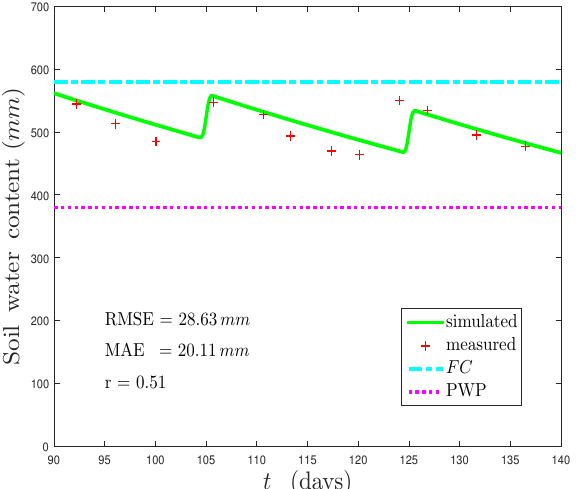
Figure 8. Soil water content trends for modeled and actual data for full irrigated wheat (using the calibrated parameters from Table 2, and measured data from Andarzian et al. [28]). Field Capacity (FC), Permanent Wilting Point (PWP), Root Mean Square Error (RMSE), Mean Absolute Error (MAE), and Pearson’s correlation coefficient